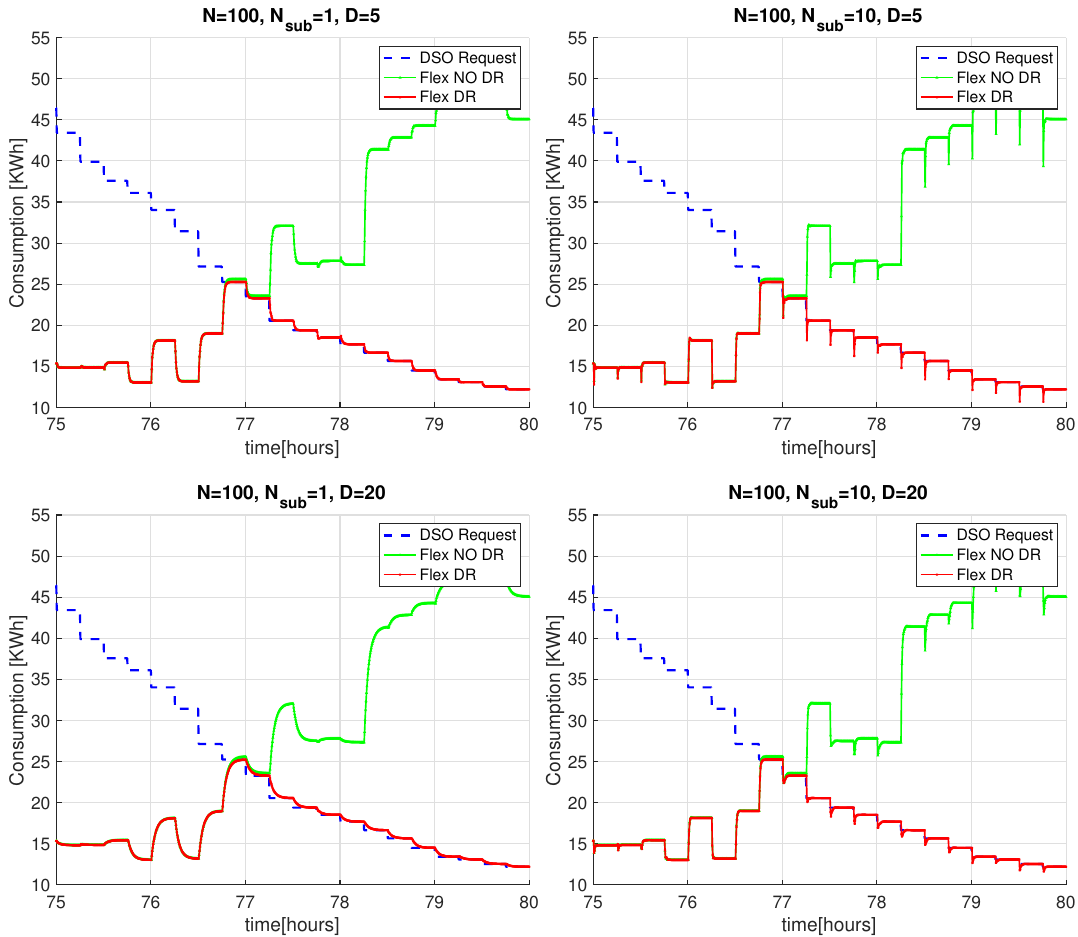
Figure 9. Detail of the PP-Overgrid convergence adaptation with N = 100 nodes, subnodes n = { 1,10 } and graph degree D = { 5,20 }